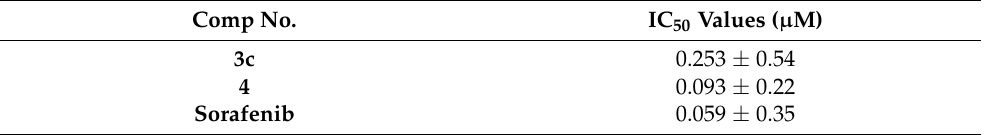
Table 2. Assessment of VEGFR-2 inhibitory activity of 1,3-thiazole derivatives 3c and 4 compared with